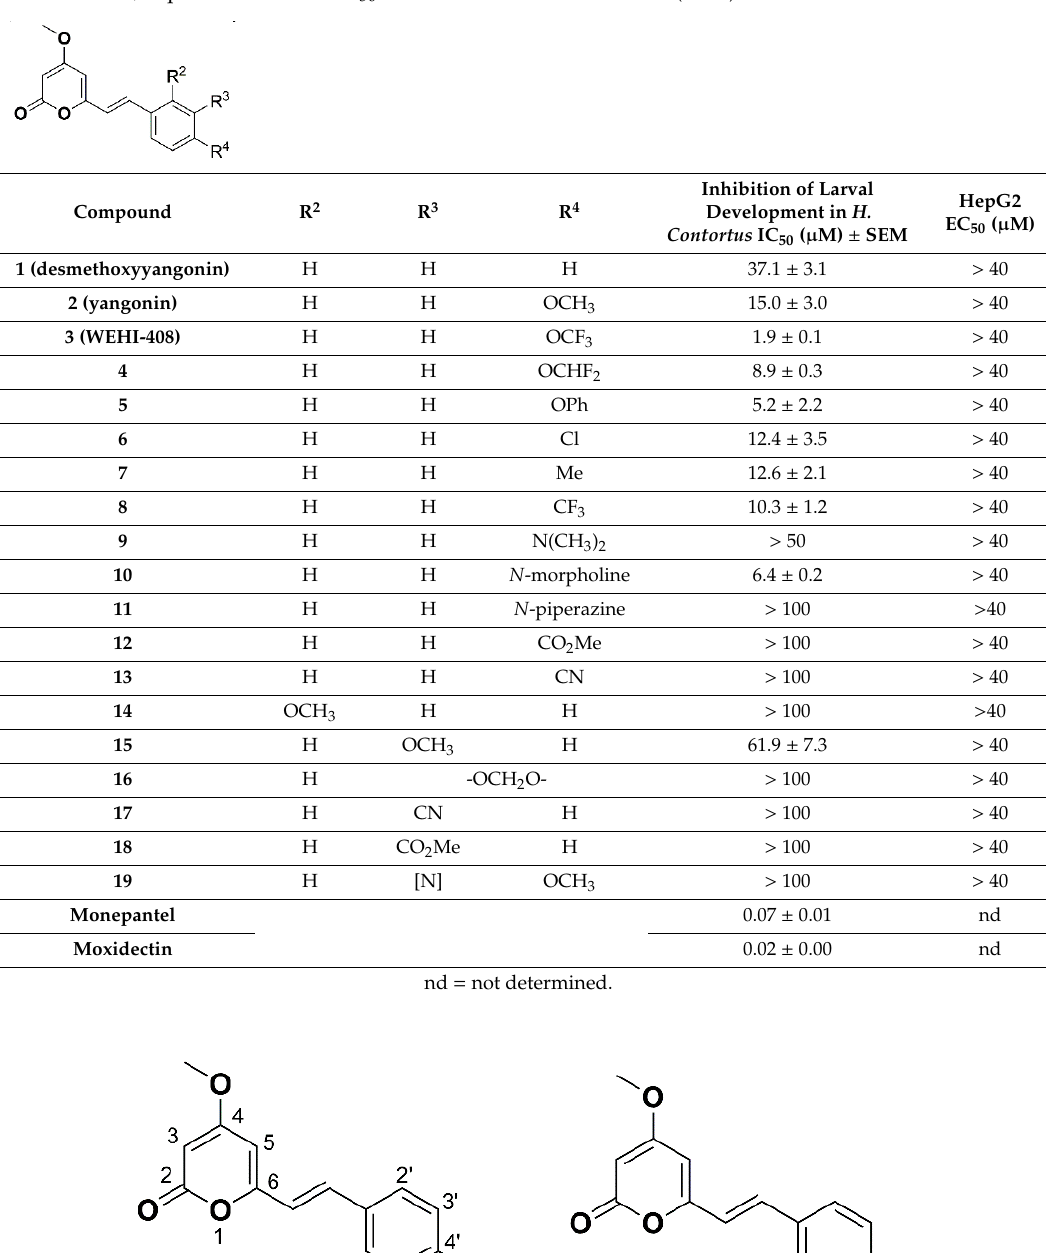
Figure 1. Structures of the natural products, yangonin and desmethoxyyangonin, and their activities against Haemonchus contortus in the larval development assay (see [7]).